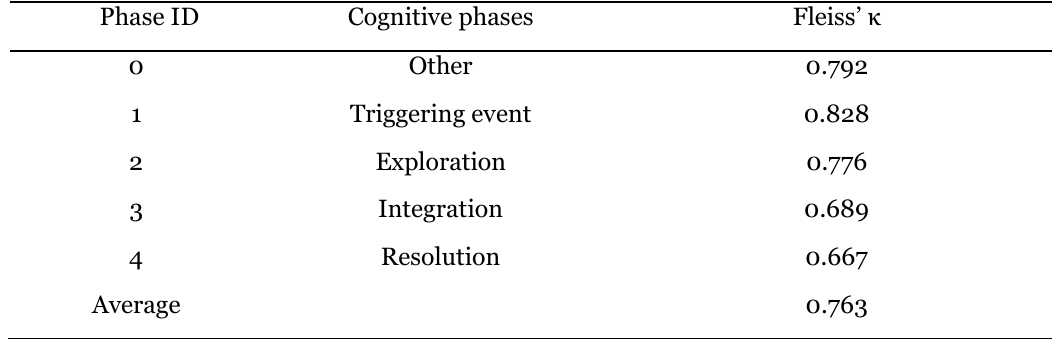
Inter-Rater Reliability Among Three Coders Across Five Categories